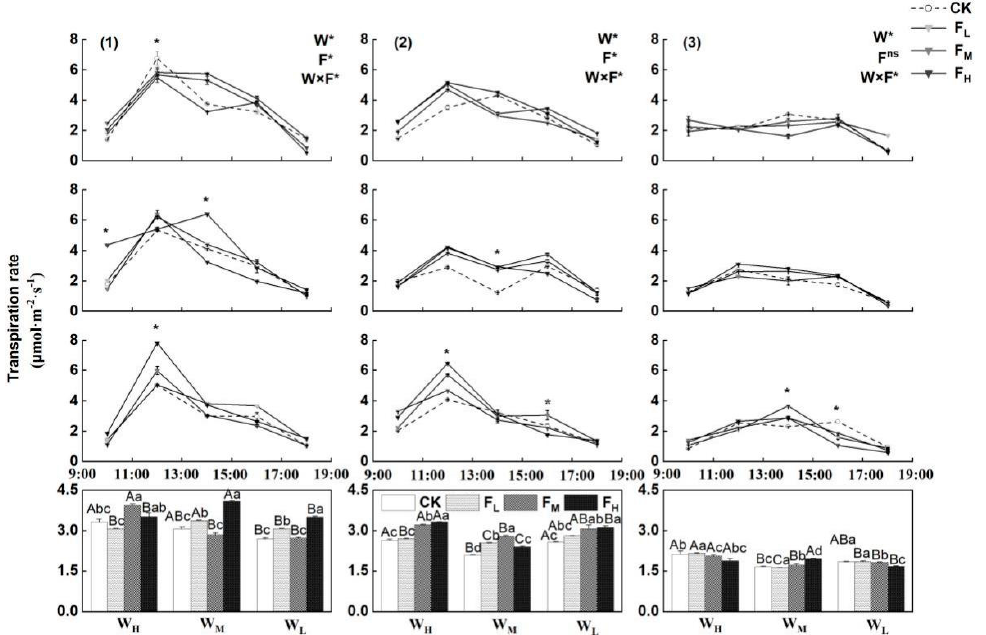
Figure 7. Changes in T r values of test plant species under different water–fertilizer treatments. Numbers ( 1 ) − ( 3 ) in brackets indicate P. crymophila , F. coelestis , and S. purpurea , respectively. W, F, and W × F indicate the results of ANOVAs ( p < 0.05) for the effects of water, fertilizer, and their interactions. Asterisk (*) and ns indicate significant difference and non-significant. The uppercase letters and lowercase letters represent the difference between water and fertilizer treatments. F. coelestis , and S. purpurea were significantly different ( p < 0.05).